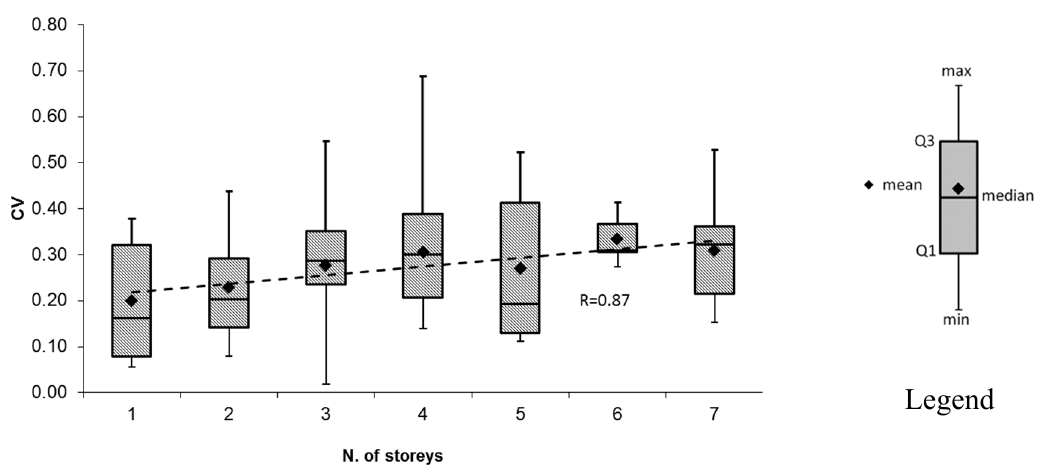
Figure 8. Box-plot of statistical data with respect to the number of storeys.